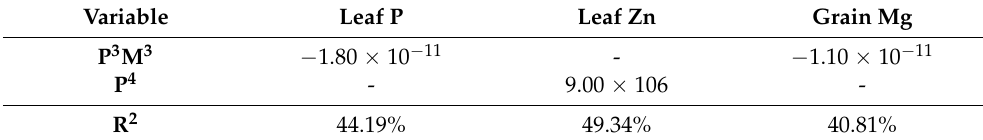
This table demonstrates the equation representing the response surface of the variables Leaf P, Leaf Zn, and Grain Mg as a function of the interaction between P 2 O 5 (P) and AMF (M) doses. For example, in Leaf P, the equation is given by: y = 2.8794 + 0.025529 · P − 24.677 · M − 0,042782 · MP − 5.0687 · P 2 + · · · + 1.928 · 10 − 9 · P 2 M 3 −